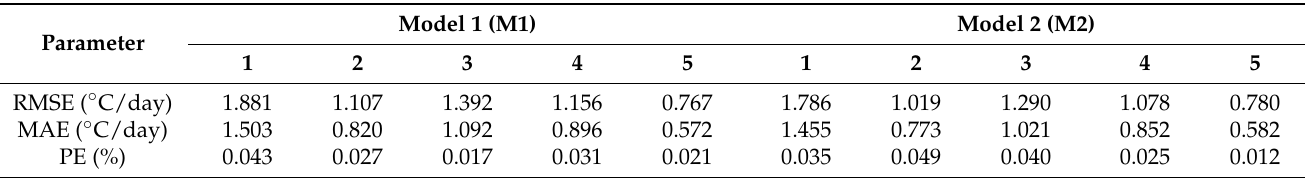
Table 3. Performance analysis for Model 1 and Model 2.